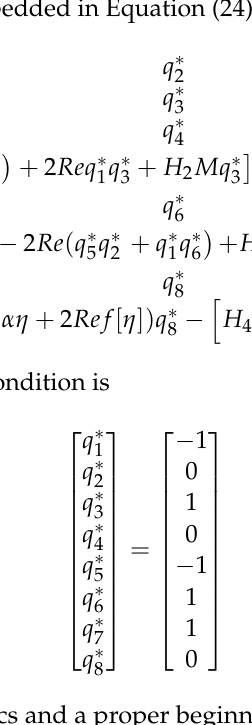
Figure 2. Flow chart of the numerical procedure (shooting method).